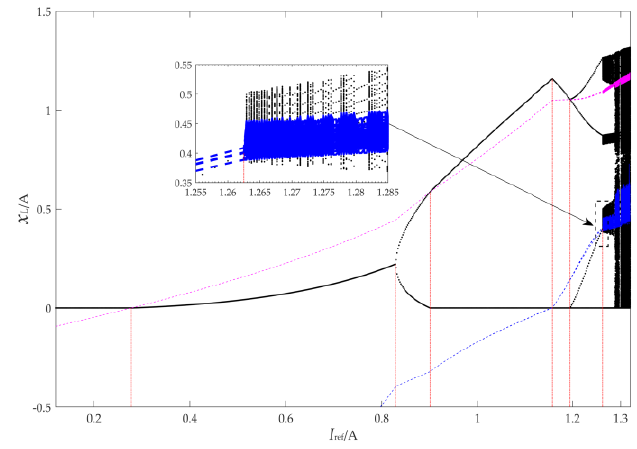
Figure 8. Bifurcation diagram of a buck converter with I ref as the changing parameter.